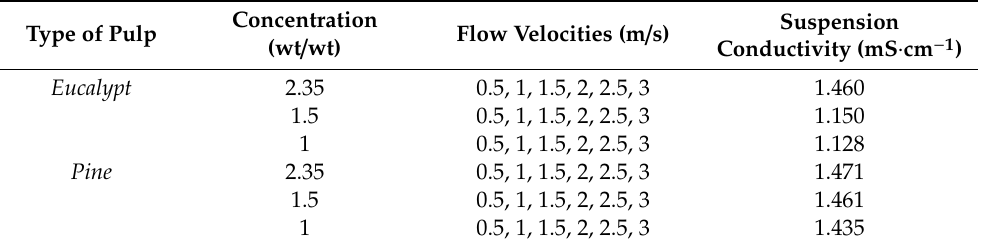
Table 1. Table of concentrations and flow velocities tested.